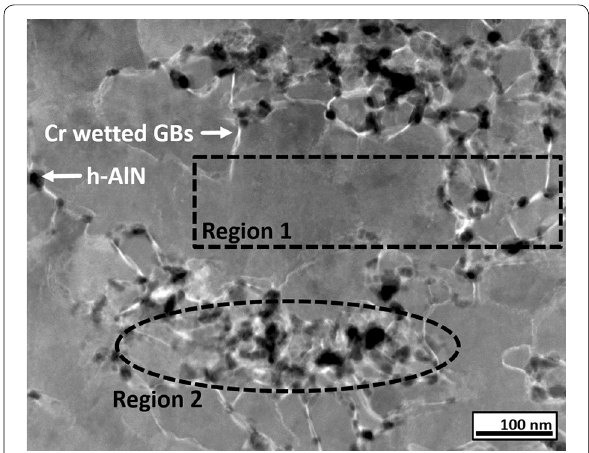
Fig. 1 a STEM‑BF cross section of the as‑deposited coating showing columnar grains within the c‑AlN/CrN region. The inset shows a SAED pattern taken from the grain marked by the white circle ; b HR‑TEM image of the c‑AlN/CrN multilayers corresponding to the white rectangle in a . Coherency between the layers is evident